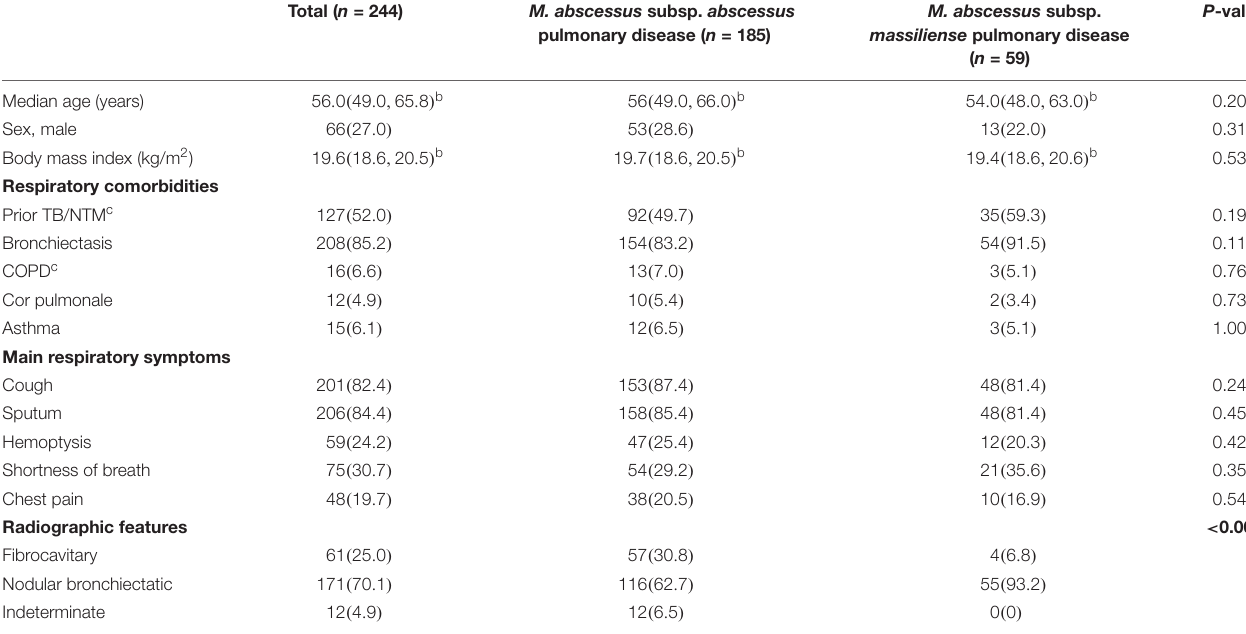
TABLE 1 | Baseline patient characteristics a